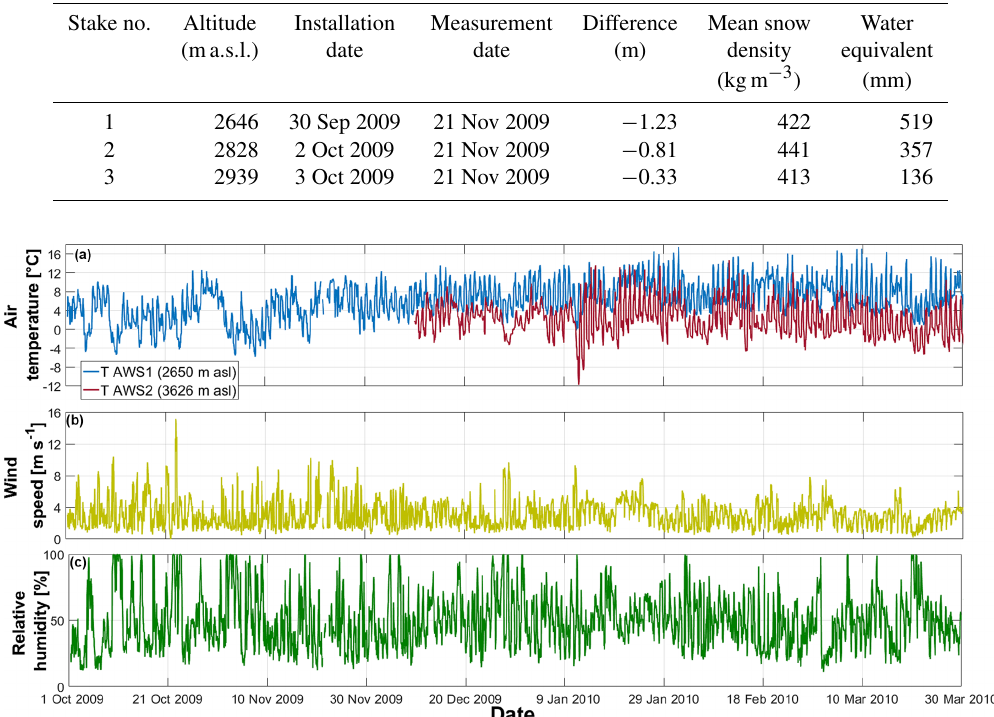
Figure 2. Hourly time series of observed meteorological variables. (a) Air temperature at AWS1 and AWS2, (b) wind speed at AWS1 and (c) relative humidity at